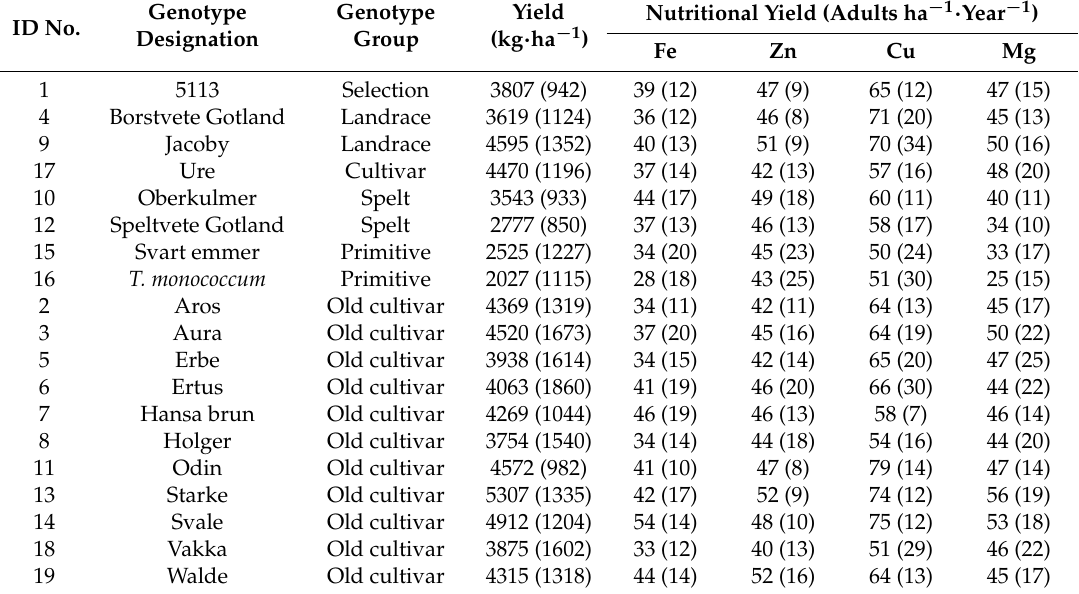
Table 2. Average values ( N = 6) for yield and nutritional yield of Fe, Zn, Cu and Mg observed in 19 winter wheat genotypes representing six genotype groups across three years of production (2012, 2013, and 2014) under organic conditions in the locality of Ekhaga. Yield values for primitive wheats and spelt wheats were adjusted in order to consider a 25% reduction due to dehulling [32]. Values in parentheses are standard deviations.